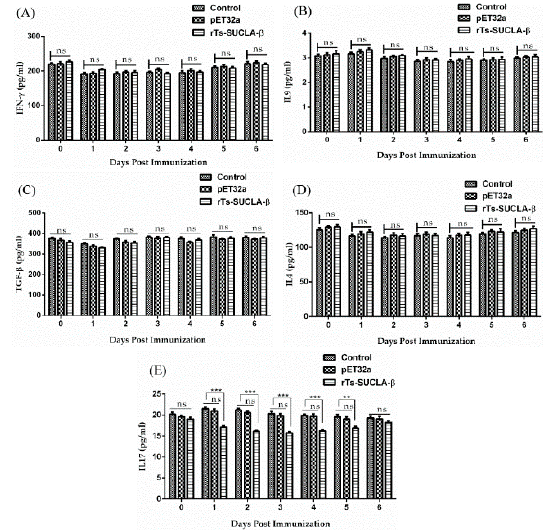
Figure 8. Effects of rTs-SUCLA- β on multiple cytokines expression in vivo. Rats were injected with rTs-SUCLA- β (PBS and purified pET-32a protein as controls). Serum from each rat was collected before injection (Day 0), 1, 2, 3, 4, 5 and 6 days after injection. Expression levels of IFN- γ ( A ), IL-9 ( B ), TGF- β ( C ), IL-4 ( D ) and IL-17 ( E ) were tested by ELISA. Significant differences were marked with ** when p < 0.01, *** when p < 0.001 and ns when non-significant. The data are expressed as the standard error mean with n = 10 in each group.